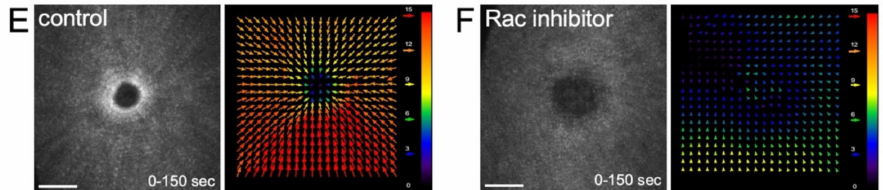
Figure 3. Spatial and temporal regulation of Rho family GTPases during cell wound repair. ( A ) XY projection confocal images of NC4–6 laser wounded Drosophila embryos co-expressing actin reporter (red) and fluorescent tagged–RhoGEFs (green; RhoGEF2, RhoGEF3, and Pebble). Used with permis- sion from Nakamura et al., (2017), J. Cell Biol. 216(12): 3959–3969. doi: 10.1083/jcb.201704145 [27]; permission conveyed through Copyright Clearance Center, Inc. ( B ) XY projection confocal im- ages of NC4–6 laser wounded Drosophila embryos co-expressing actin reporter (green in the Rho1 and Cdc42 panels and red in the Rac1 panel) and fluorescent tagged-Rho1 (red), -Cdc42 (red), or -Rac1 (green). Used with permission from Nakamura et al., (2017), J. Cell Biol. 216(12): 3959–3969. doi: 10.1083/jcb.201704145 [27]; permission conveyed through Copyright Clearance Center, Inc. ( C ) Schematic diagram showing the recruitment patterns of RhoGEFs and Rho family GTPases to wounds relative to the actin ring and halo. ( D ) XY confocal images of laser wounded Xenopus oocyte co-expressing Rho (green) and Cdc42 (magenta) biosensors. Reprinted from Golding et al., (2019), eLife 8: doi:10.7554/eLife.50471 [21]. ( E , F ) XY projection confocal images of NC4–6 laser wounded Drosophila embryos expressing an actin reporter in control ( E ) and Rac inhibitor injected ( F ) embryos. Cortical actin flow analysis by projection from 0 to 150 s post-wounding (left panels). Vector map of particle image velocimetry indicating actin flow speed and direction between 90 and 120 s (right panels). Arrow magnitude represents the flow rate in pixels. Scale bar: 20 µ m ( A , B , E